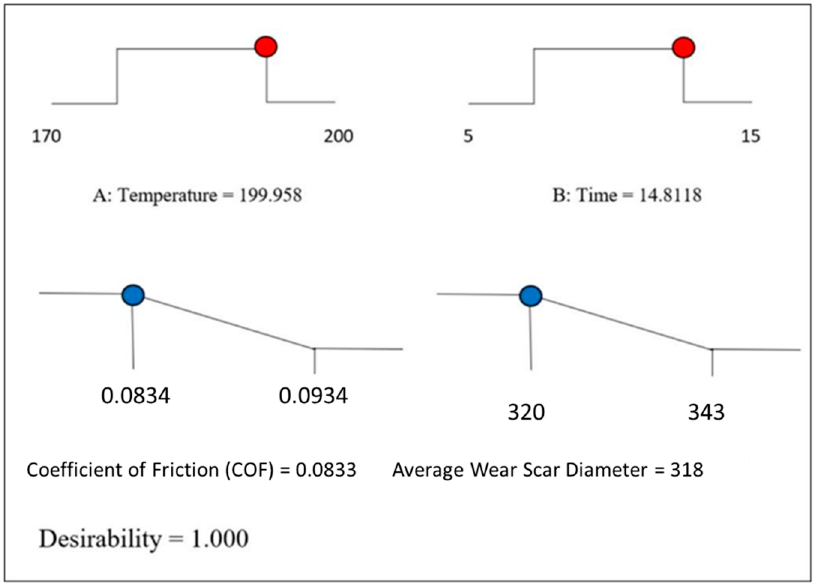
Figure 16. The ramp function plot for the optimization of the MoS 2 nanolubricants. Table 8. The model validation for the MoS 2 nanolubricants.